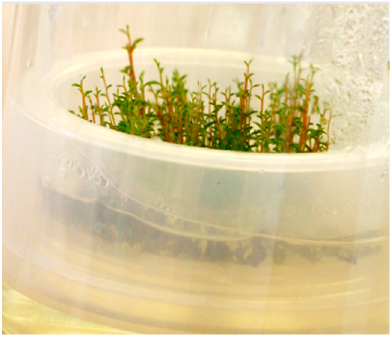
Figure 2. Shoot proliferation in lingonberry.